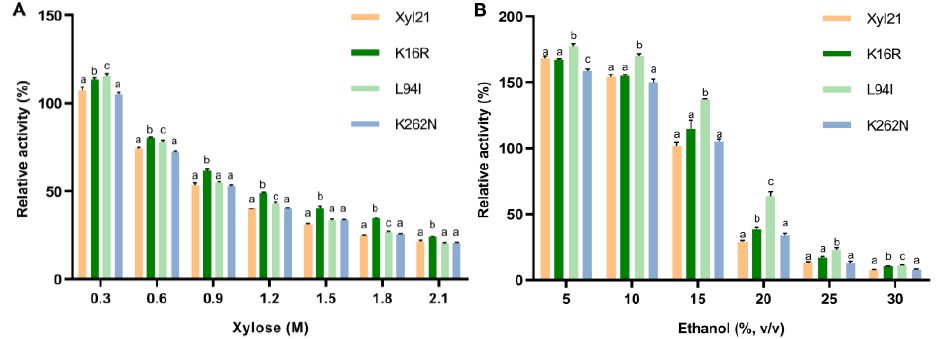
Figure 6. The xylose ( A ) and ethanol ( B ) tolerance of single site mutants K16R, L94I, K262N compared to wild type Xyl21. All data were collected from at least three biological replicates and are shown as the mean ± SD. Bars indicated by the same letter are not significantly different ( p > 0.05, evaluated by t -test).